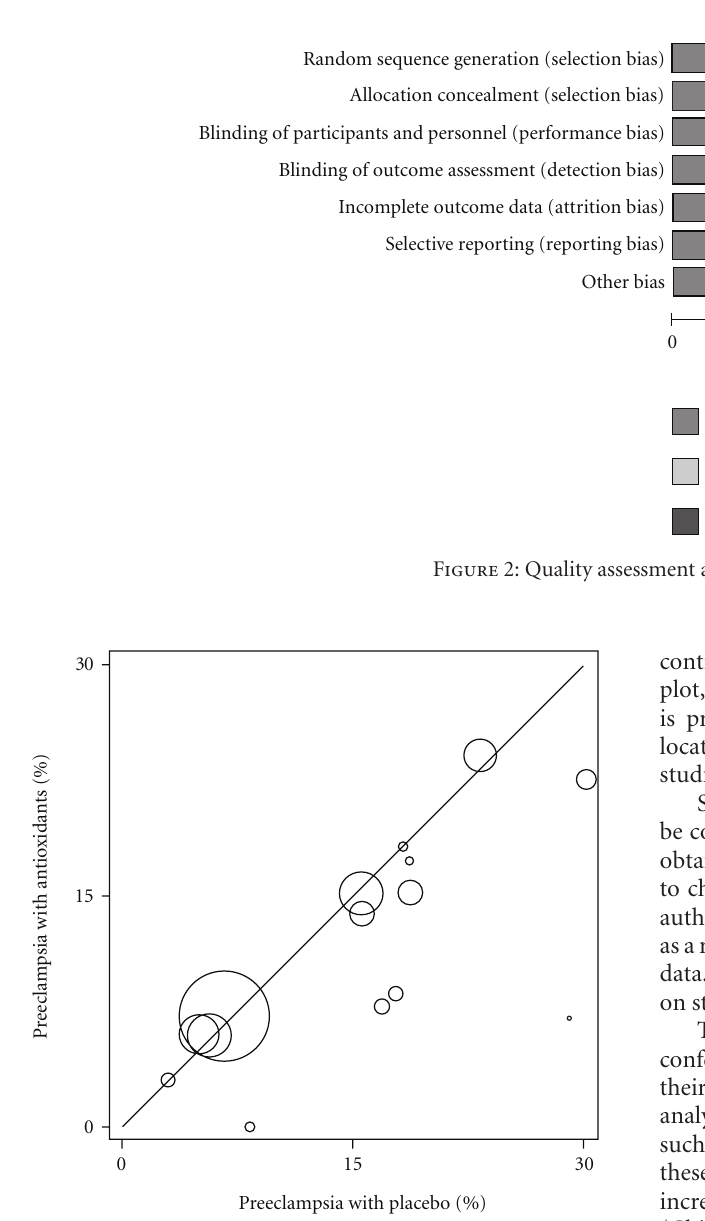
Figure 3: Preeclampsia incidence proportion with antioxidants and placebo